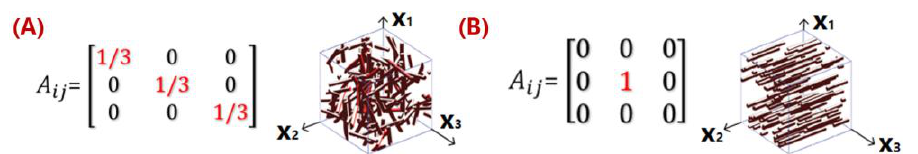
Figure 7. Fiber orientation tensors for ( A ) uniformly random alignment and ( B ) fully aligned along x 2 direction.